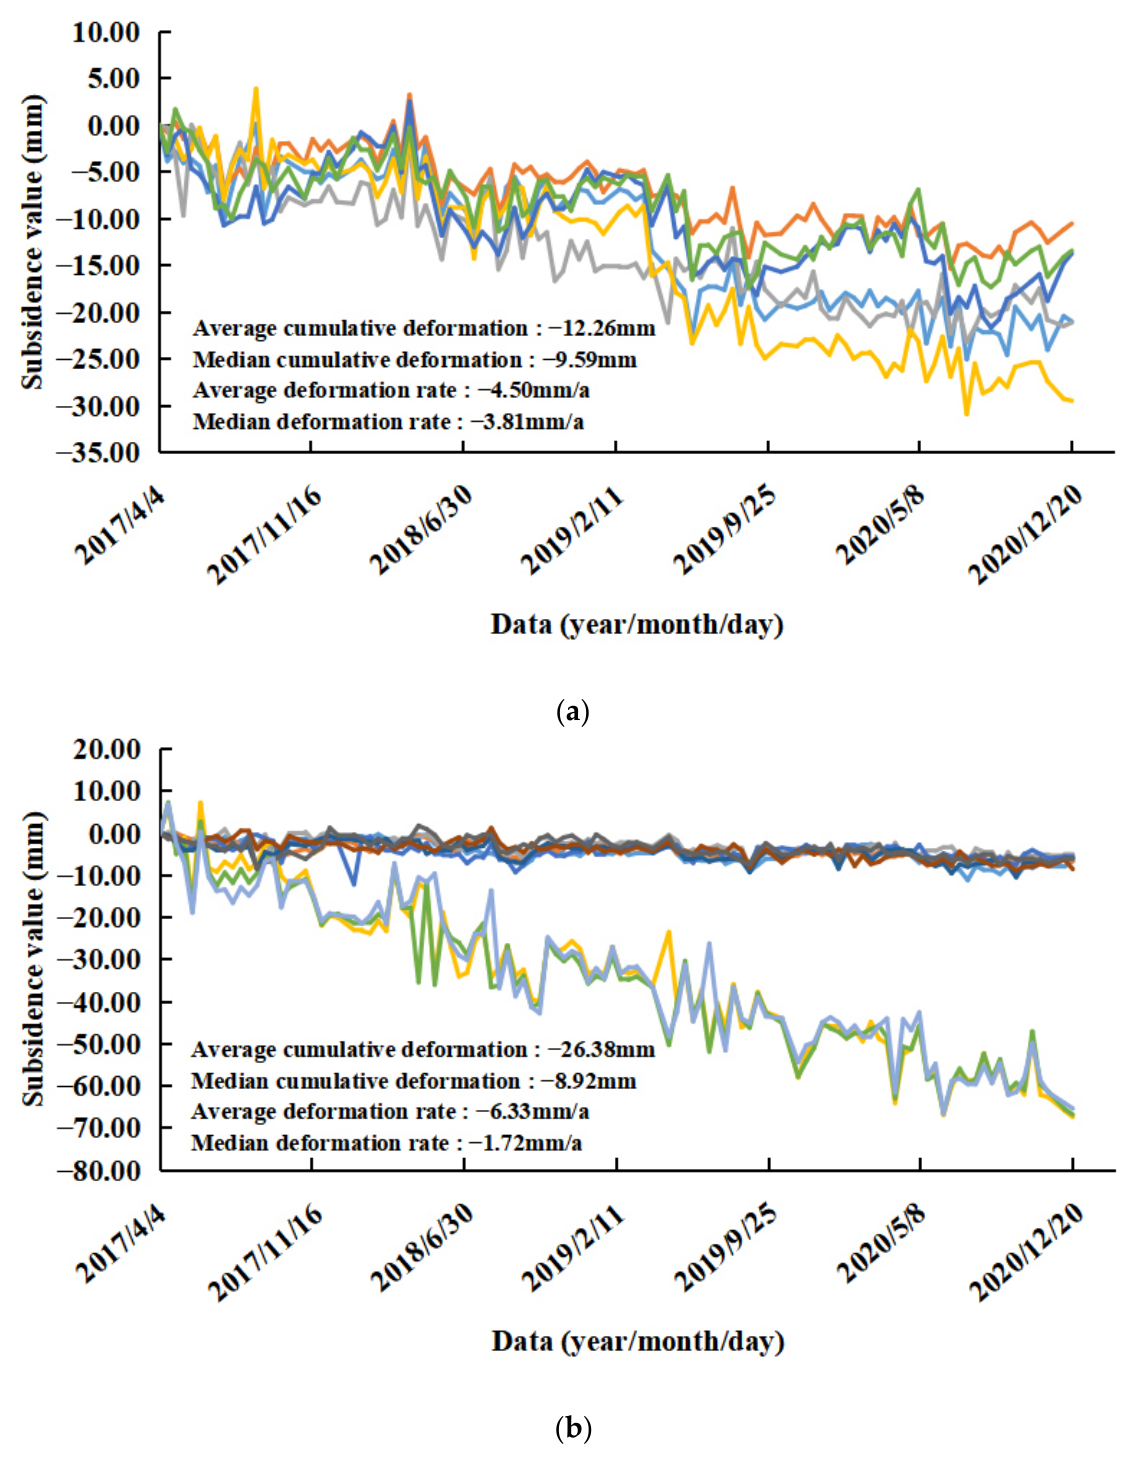
Figure 16. Part of the PS points subsidence of the concentrated subsidence area in Areas C and E: ( a ) Area C and ( b ) Area E. (Different colors represent different PS points).